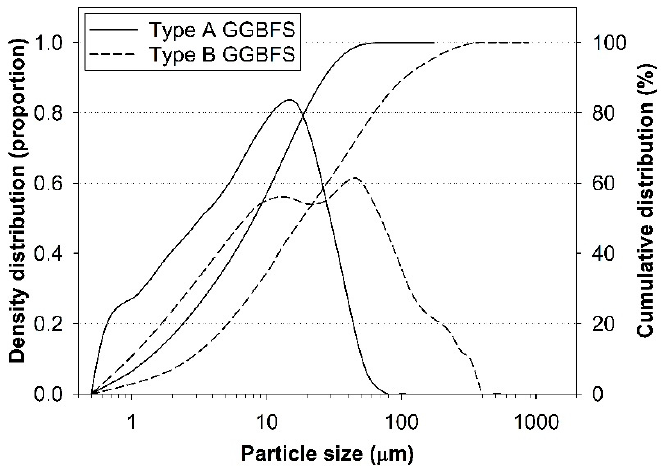
Figure 2. Particle size distributions of the raw GGBFS materials.